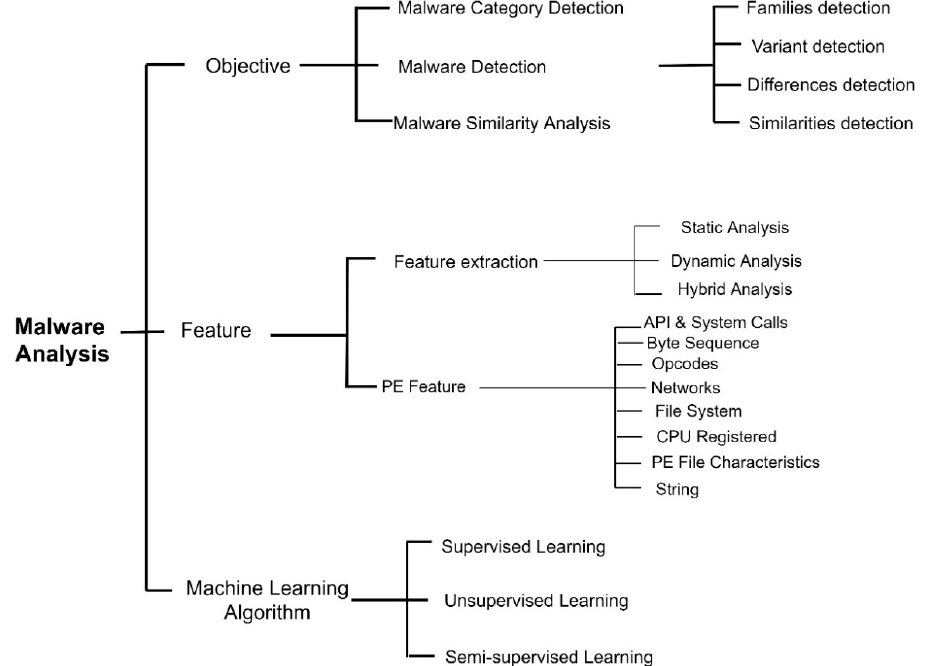
Figure 4. Malware analysis methods [17].